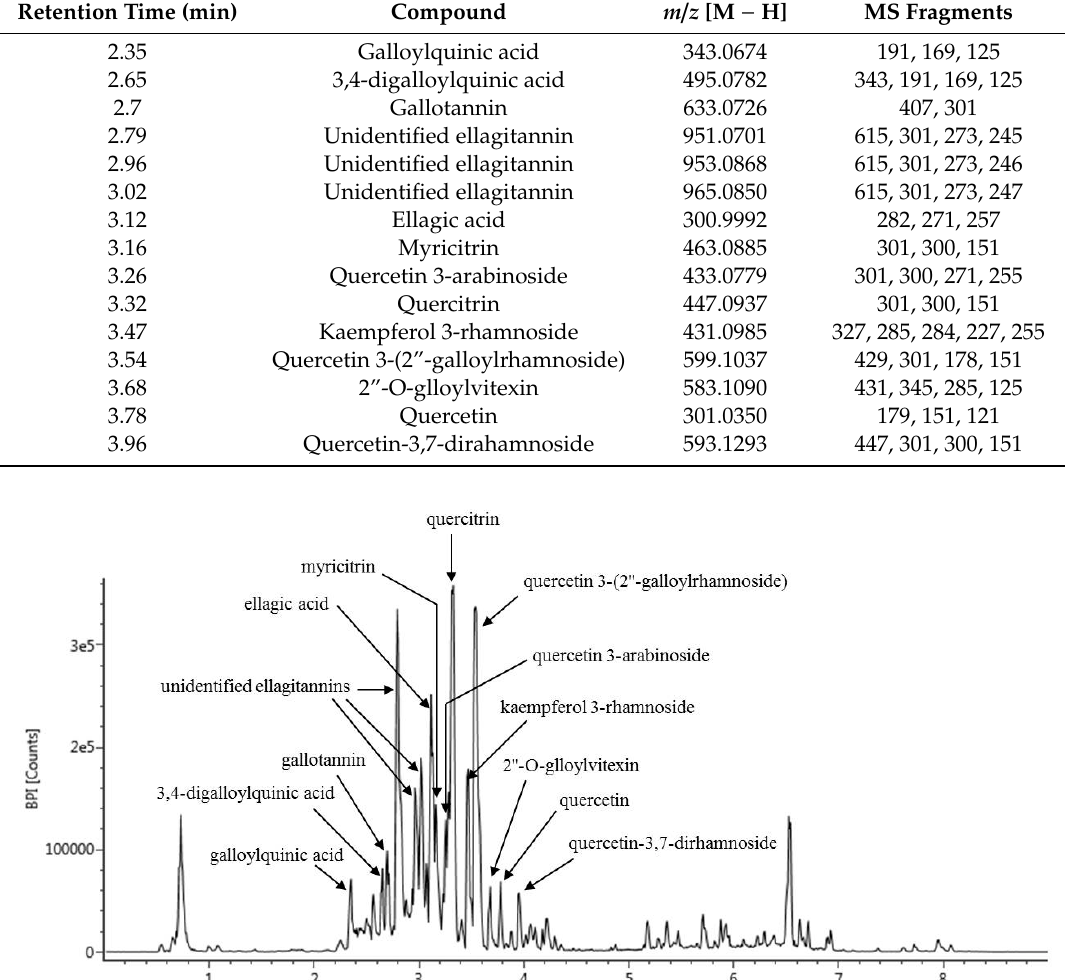
Table 1. Identification of phenolic compounds from C. turczaninowii extract using ultra-performance liquid chromatography-quadrupole-time of flight mass spectrometry (UPLC-Q-TOF MS).